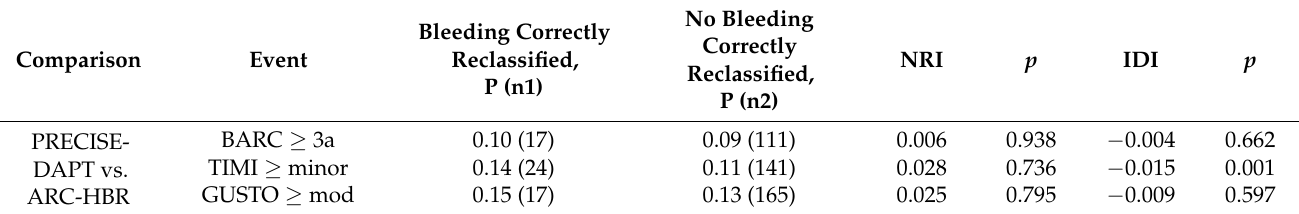
Table 6. Net reclassification improvement and integrated discriminatory improvement for 1-year